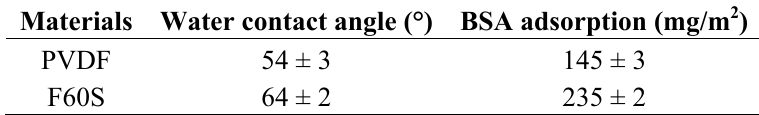
Table 3. Water contact angle and BSA adsorption of the PVDF and F60S membranes.